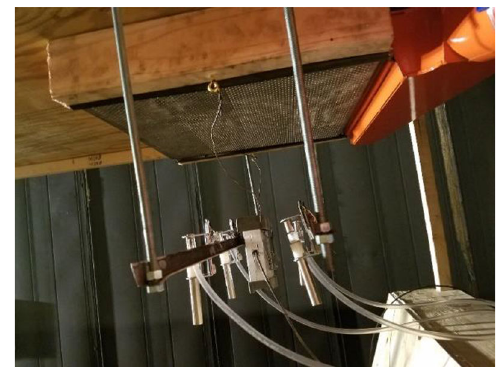
Fig. 6 Photo showing the sampling locations, both the pDR-1000 and 4 gravimetric samplers, underneath